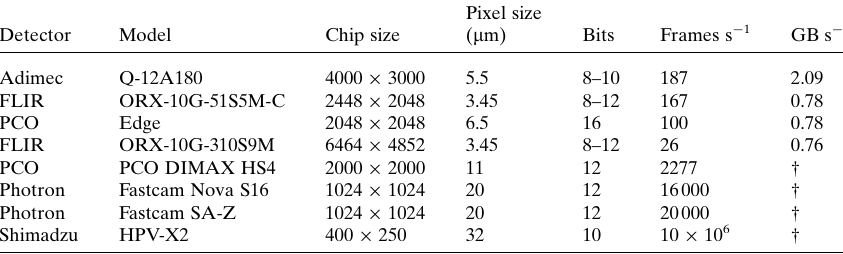
Table 3 Characteristics of fast detectors available at the Imaging Group of APS.